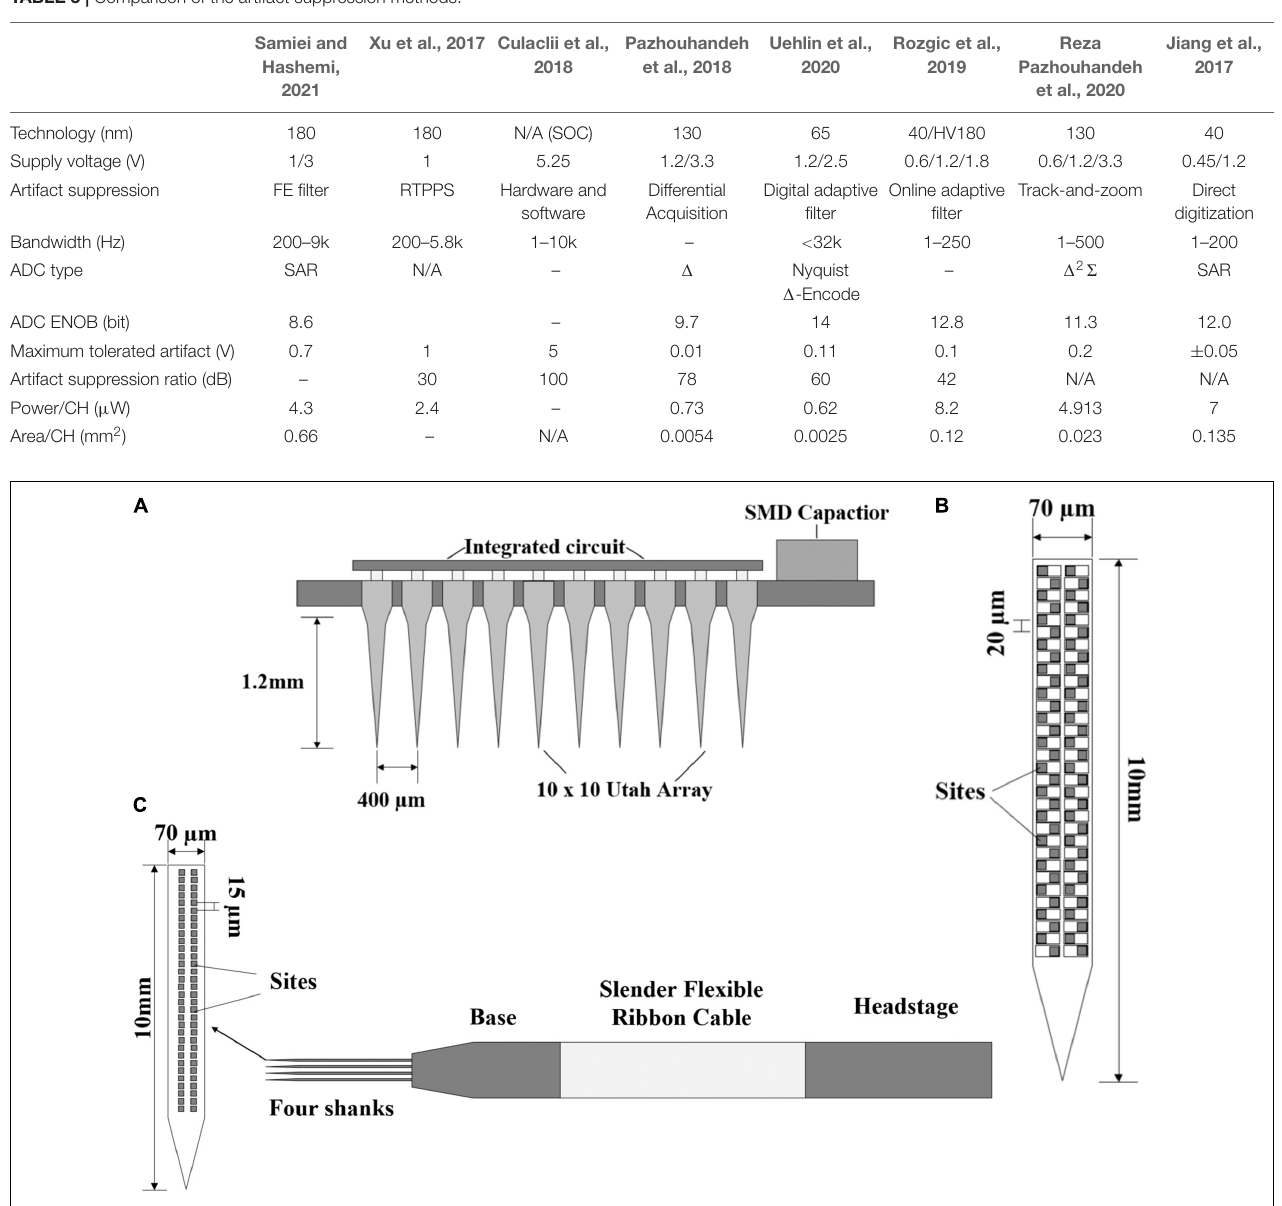
TABLE 3 | Comparison of the artifact suppression